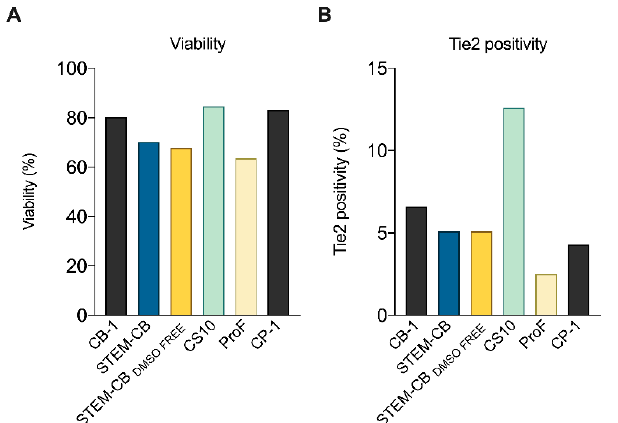
Figure 6. Comparison of 6 types of cryopreservation solutions, namely CELLBANKER 1 (CB-1), STEM-CELLBANKER GMP grade (STEM-CB), STEM-CELLBANKER DMSO Free GMP grade (STEM-CB DMSO FREE ), CryoStor ® CS10 (CS10), and Pro Freeze™-CDM (ProF). Nucleus pulposus cells suspended in the cryopreservation solutions and kept on ice for 3 h before cryostoring them for 1 day. The cells were recovered and cultured for 5 days. Subsequently, the ( A ) viability rate and the ( B ) fraction of Tie2 positive cells were determined. Data is presented as mean values with error bars presenting standard deviation.